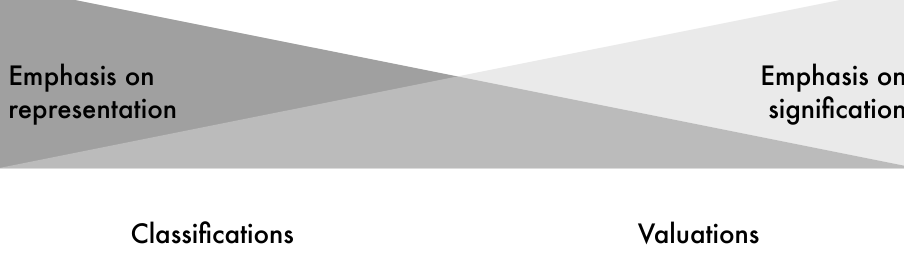
Figure 1. Valuation and classification as ordering practices with different